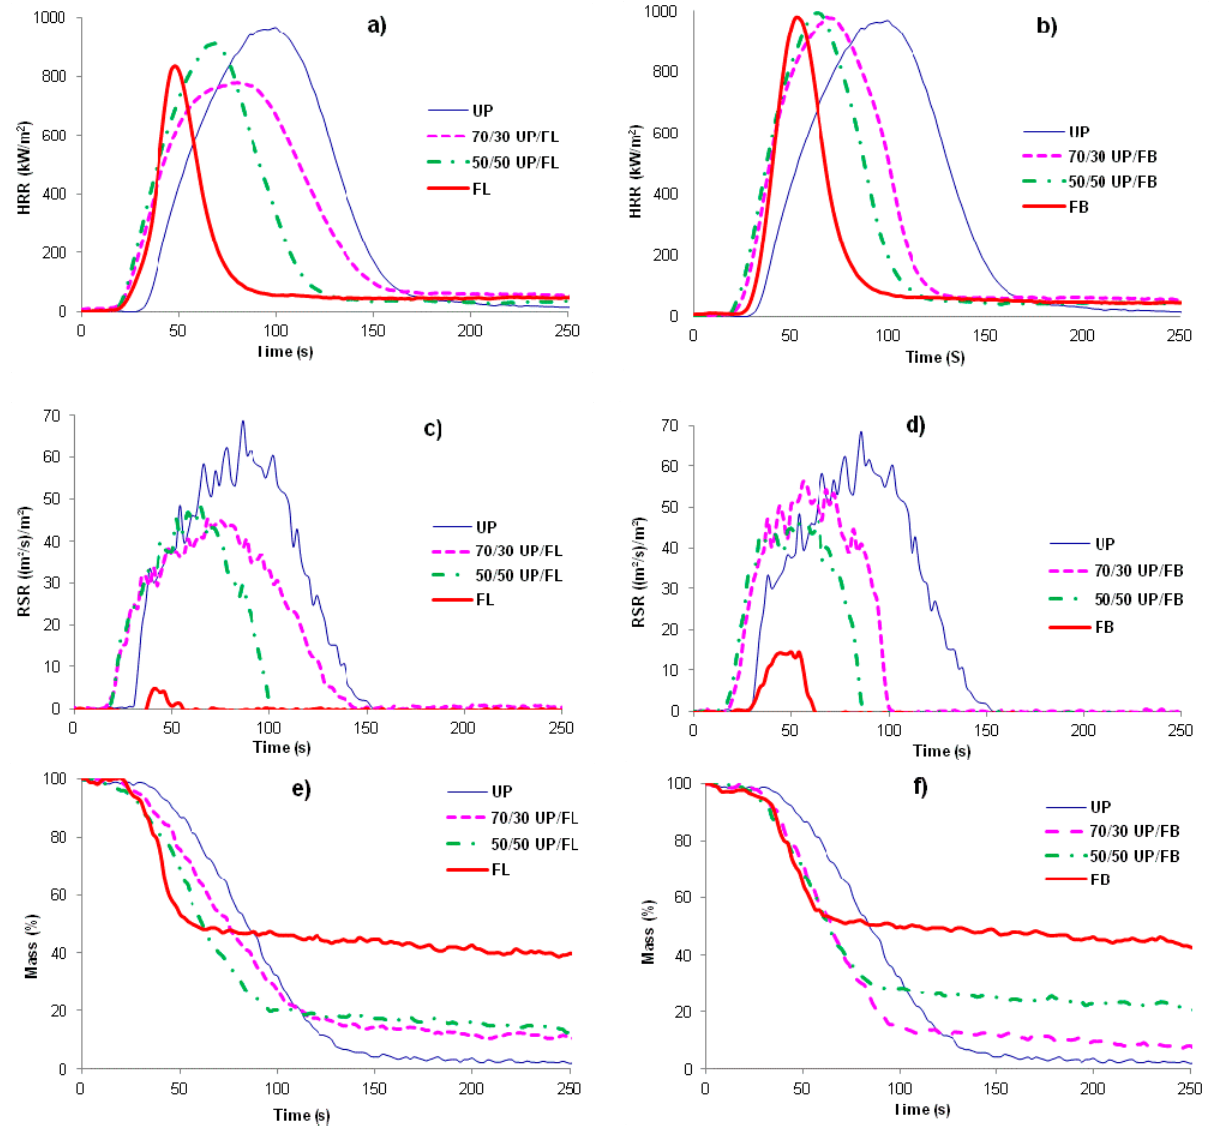
Figure 5. HRR vs . time for ( a ) UP/FL cured resins and resin blends and ( b ) for UP/FB cured resins and resin blends; ( c ) and ( d ) are RSR vs . time plots for the same systems and ( e ) and ( f ) plots of mass vs . time plots obtained by cone